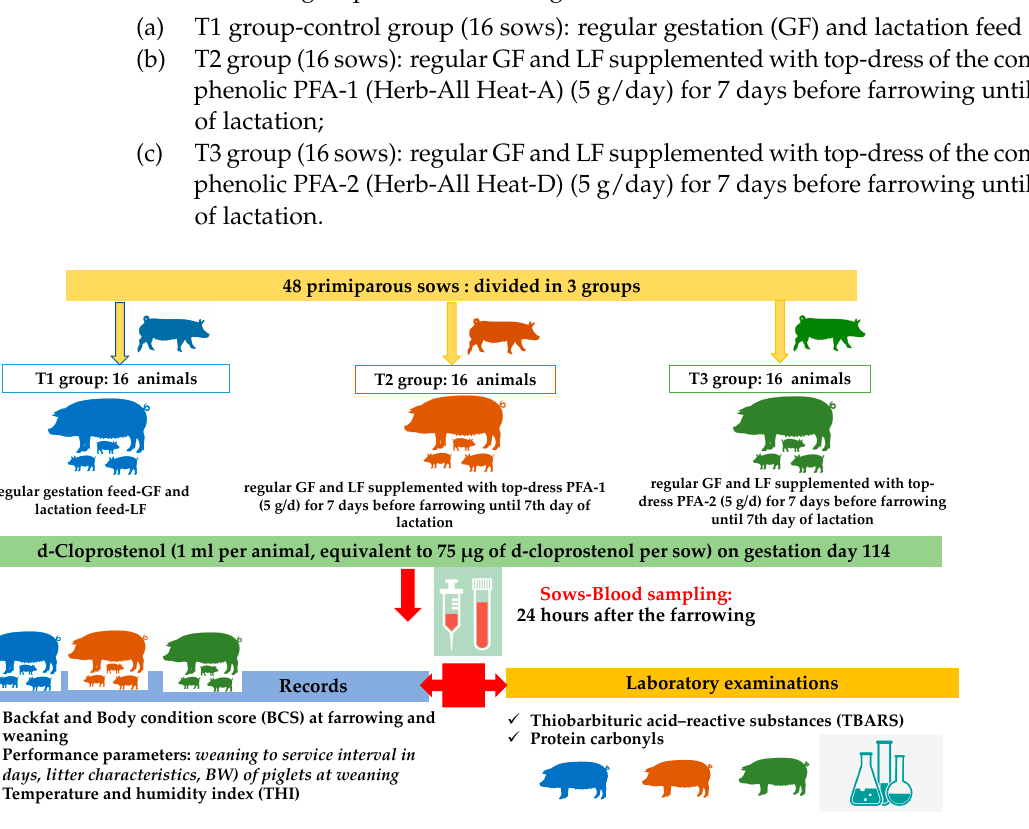
Figure 1. An overview of experimental design, records, samplings, and tests performed.